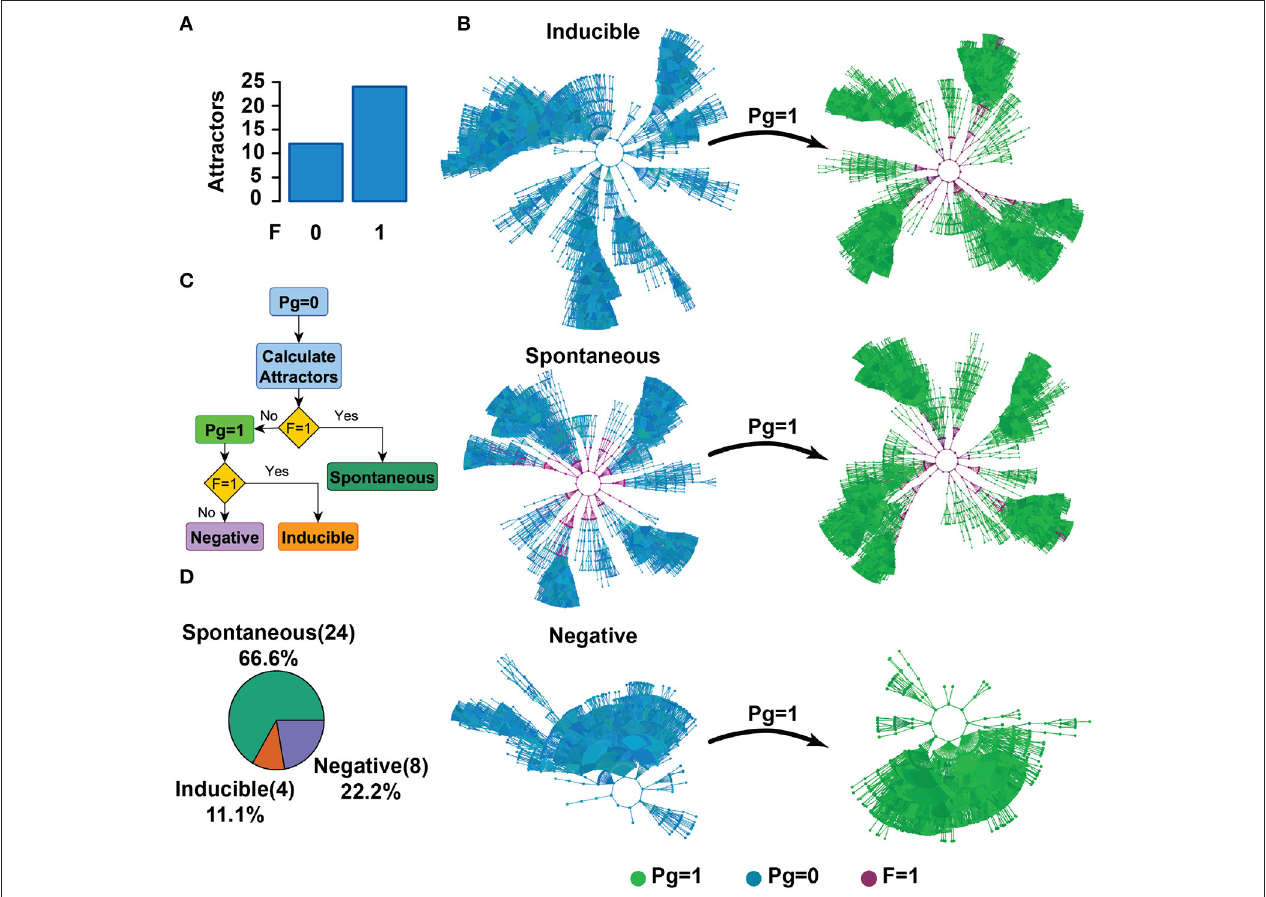
FIGURE 4 | Attractor landscape partitions into three functional groups: Spontaneous, Inducible, and Negative. (A) The number of attractors reaching a membrane fusion state ( F = 1) or lack of it ( F = 0) in the absence of Pg ( Pg = 0). (B) Diagram of the classification criteria of the attractor space in three functional groups. Colors represent the activity of the Pg node and the reporter node Fusion (F); blue dots correspond to states where Pg = 0, whereas green dots indicate Pg = 1. Purple dots represent states reaching F = 1. Considering the attractors of (A) , Spontaneous attractors present membrane fusion ( F = 1) in the absence of Pg, in which case Pg addition does not affect the membrane fused state [these attractors correspond to the second bar of (A) ]. From the remaining attractors that do not present membrane fusion ( F = 0), Inducible attractors are those where the fusion state ( F = 1) is reached only after a Pg stimulus ( Pg = 1). Negative attractors never reach the fusion state ( F = 1) regardless of the value of Pg. (C) Flow diagram of the classification criteria described in (B) . (D) Distribution of attractors in the absence of Pg ( Pg = 0), classified in terms of their response to